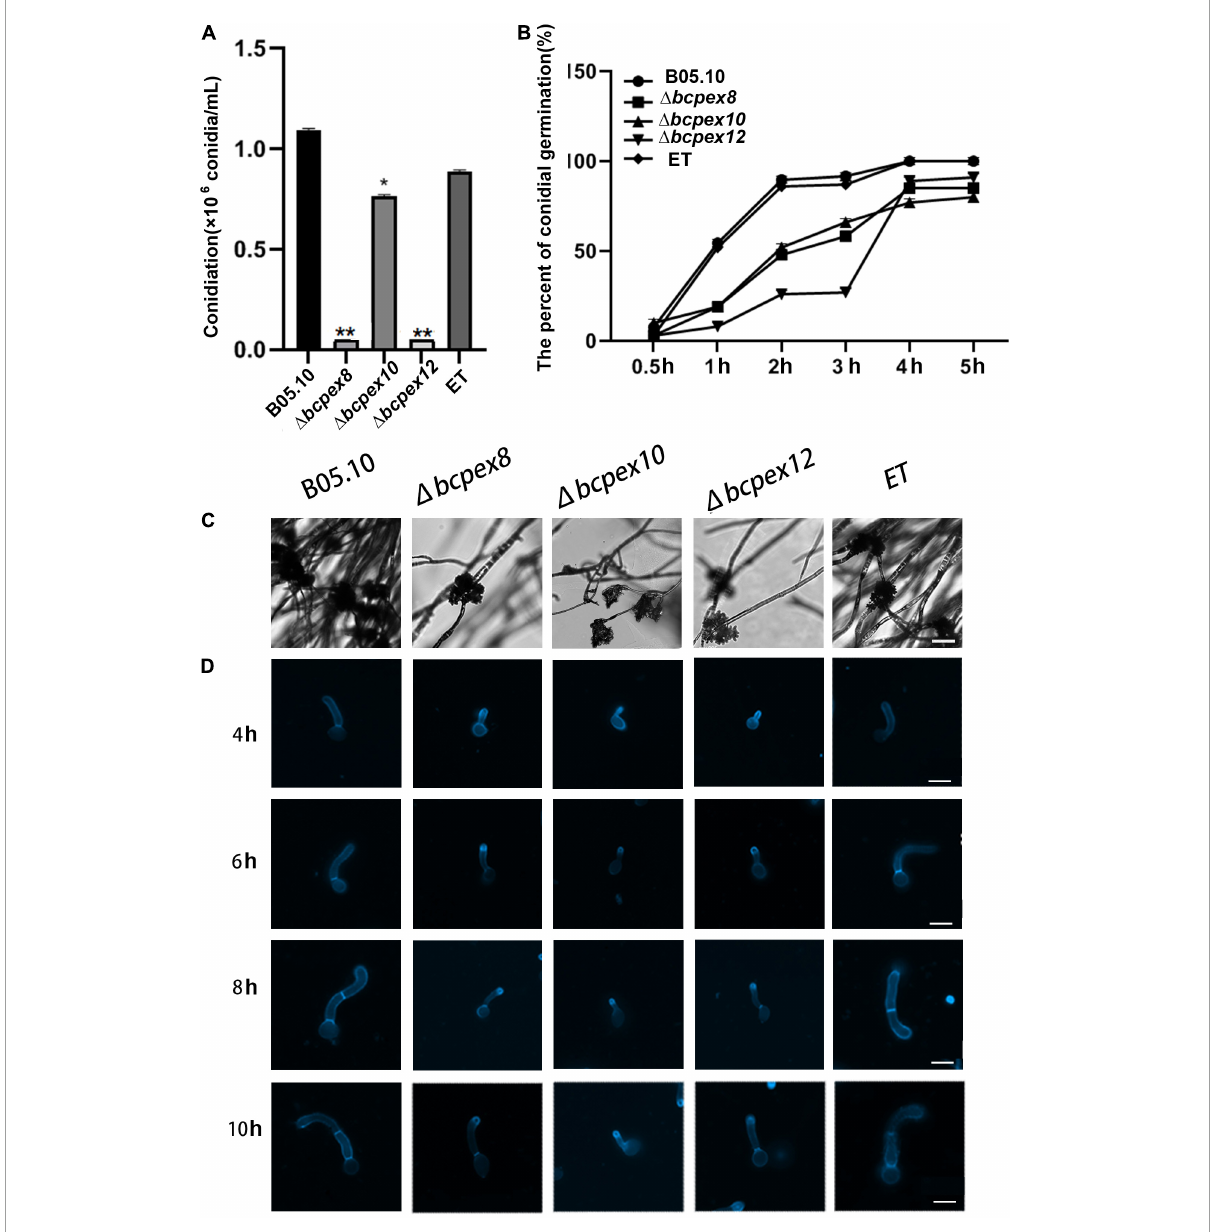
FIGURE4 The asexual development of (cid:49) bcpex8 , (cid:49) bcpex10 , (cid:49) bcpex12 mutants and WT and ET strains. (A) Conidiation of (cid:49) bcpex8, (cid:49) bcpex10 , (cid:49) bcpex12 mutants and WT and ET strains. (B) The conidial germination rate of (cid:49) bcpex8, (cid:49) bcpex10 , (cid:49) bcpex12 mutants and WT and ET strains. (C) Observation of conidiophore cluster of (cid:49) bcpex8 , (cid:49) bcpex10, and (cid:49) bcpex12 mutants and WT and ET strains. Bar = 200 µ m. (D) Germ tube elongation of (cid:49) bcpex8 , (cid:49) bcpex10, and (cid:49) bcpex12 mutants and WT and ET strains. The spores were stained with CFW. Bar = 20 µ